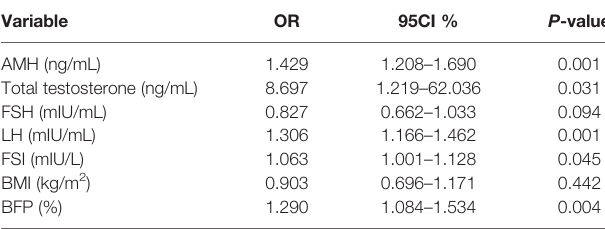
TABLE 3 | Multivariable logistic regression